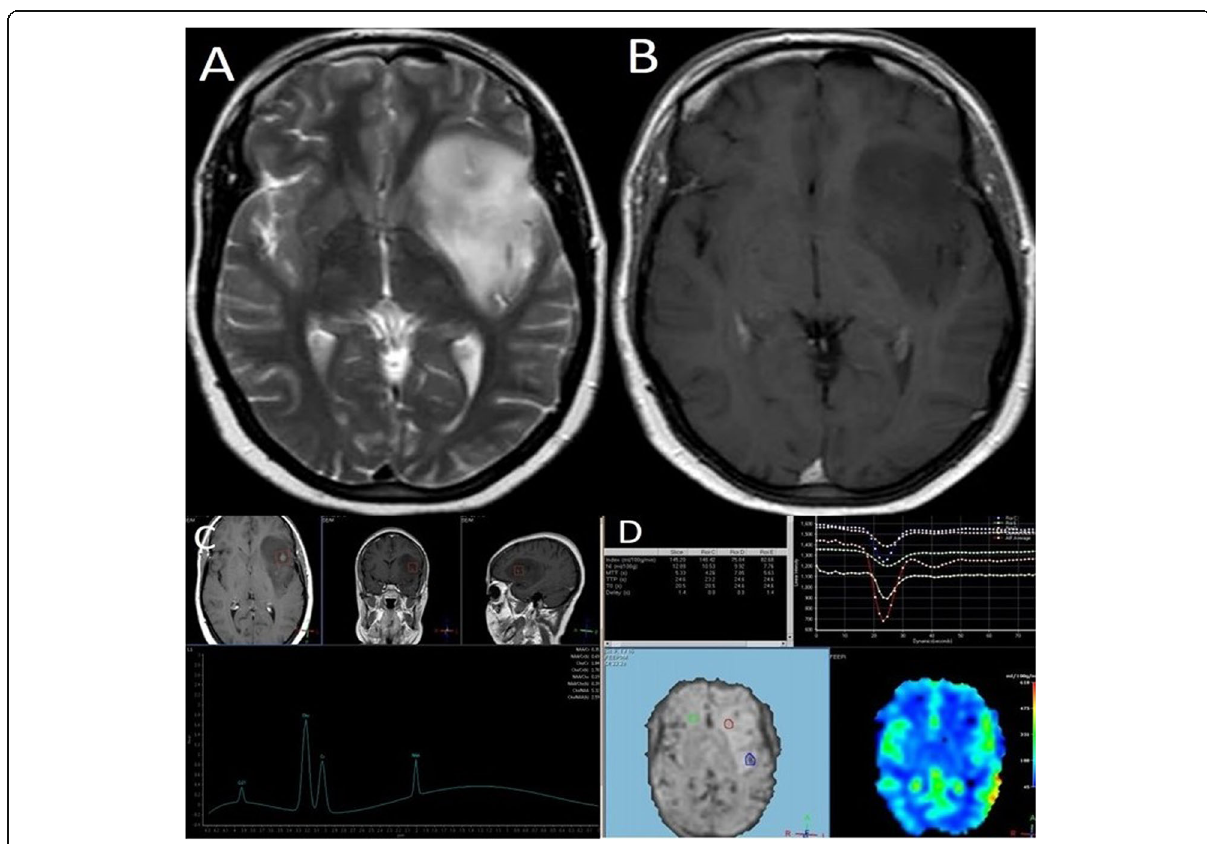
Fig. 2 A 26-year-old female presented by gradual behavior changes and right hemiparesis for 2 months. a Axial T2WI showing a large rather defined mass in left frontotemporal showing hyperintense signal, surrounded by mild vasogenic edema. b Axial T1 post Gd showing no enhancement. c Intermediate echo spectroscopy curve shows Cho/Cr ratio 1.5 and Cho/NAA ratio 1.8. d Perfusion-weighted images PWI and rCBV color perfusion map for the lesion and edema show a mild signal drop of the lesion and area of relative hyper-perfusion rCBV 1.5, also for edema rCBV 0.7. Collectively, the findings are in favor of LGG. Histopathological examination confirmed the diagnosis: diffuse astrocytoma WHO GRADE II